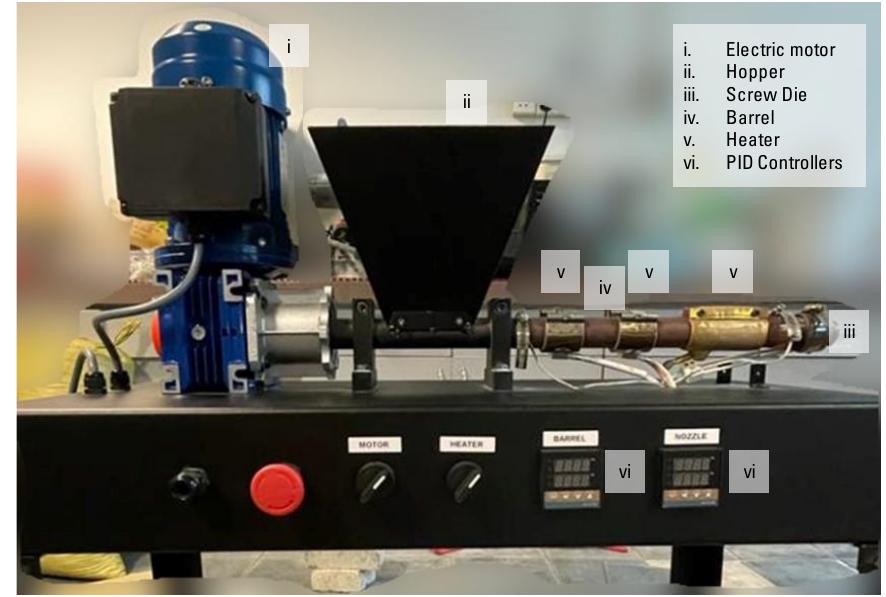
Figure 7. The single-screw extruder.